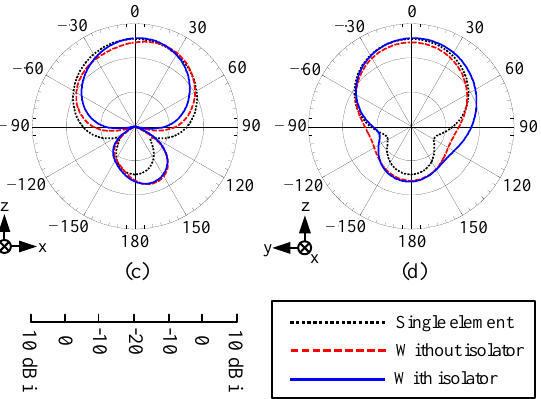
Figure 11. Radiation patterns of a field-domain SICS [58]. ( a ) State 1, xz plane, ( b ) State 1, yz plane, ( c ) State 2, xz plane, ( d ) State 2, yz plane.